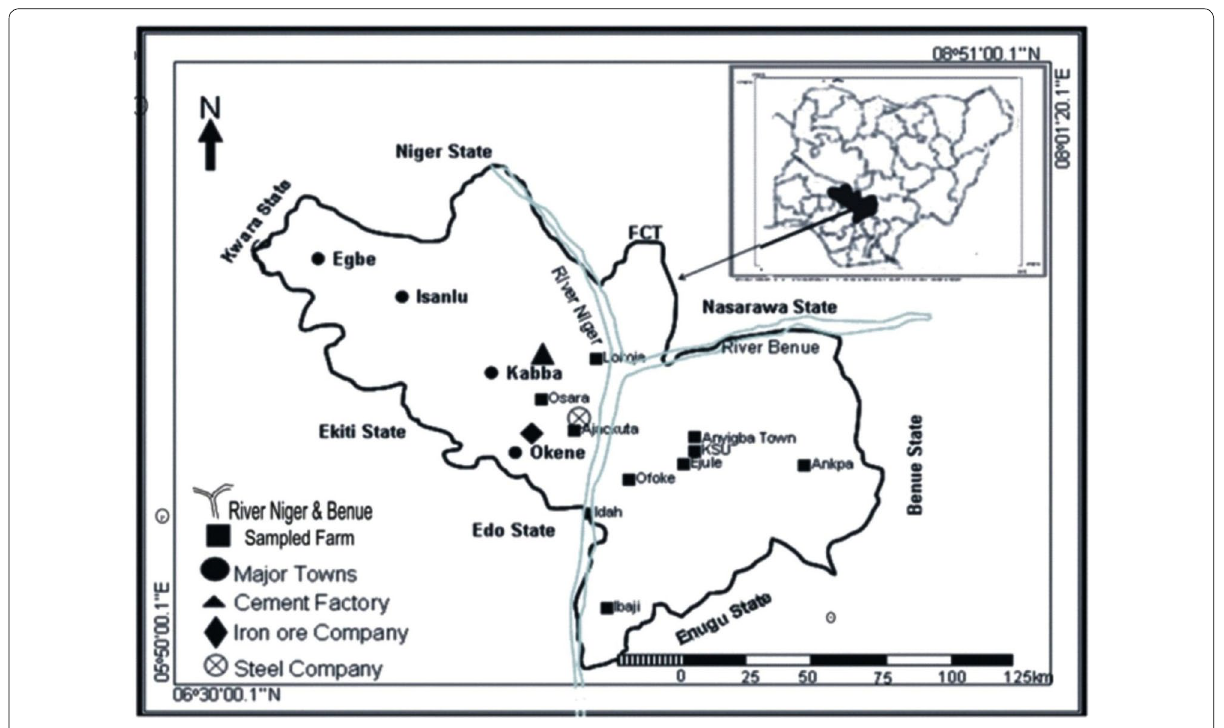
Fig. 1 Sampled farmlands